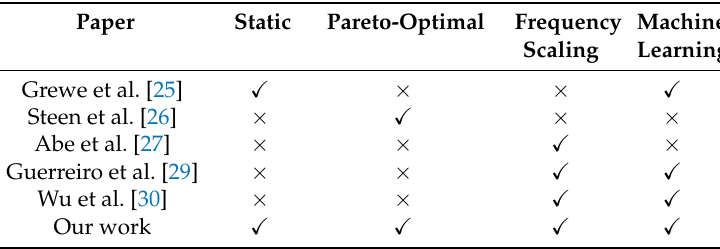
Table 1. Comparison against the